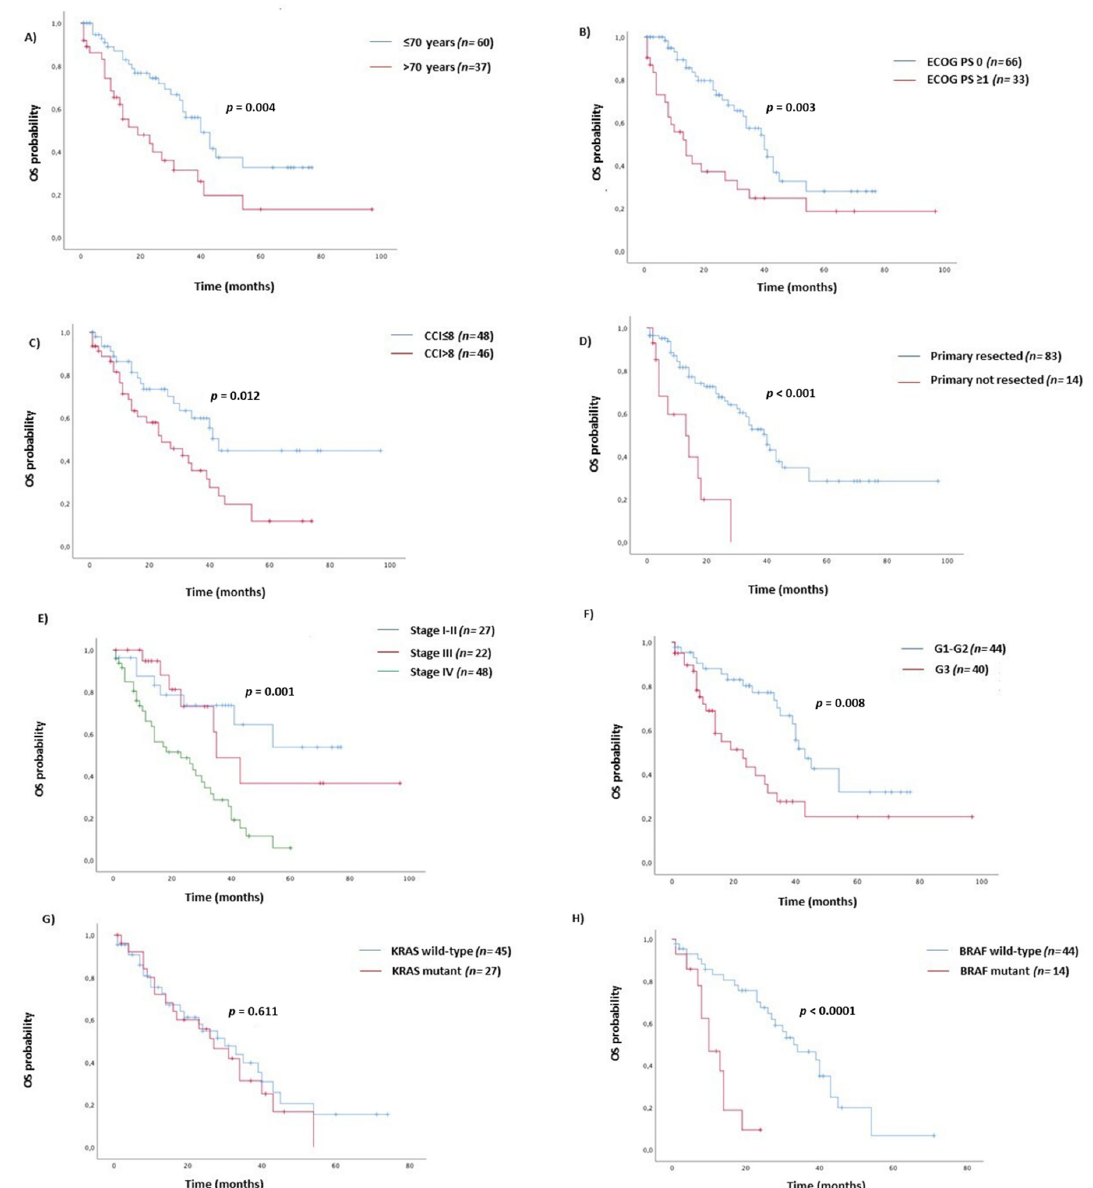
Figure 2. Kaplan–Meier curves for OS according to age ( A ), ECOG PS ( B ), Charlson Comorbidity Index ( C ), primary tumor surgery ( D ), TNM Stage ( E ), tumor grade ( F ), KRAS status ( G ), and BRAF status ( H ).